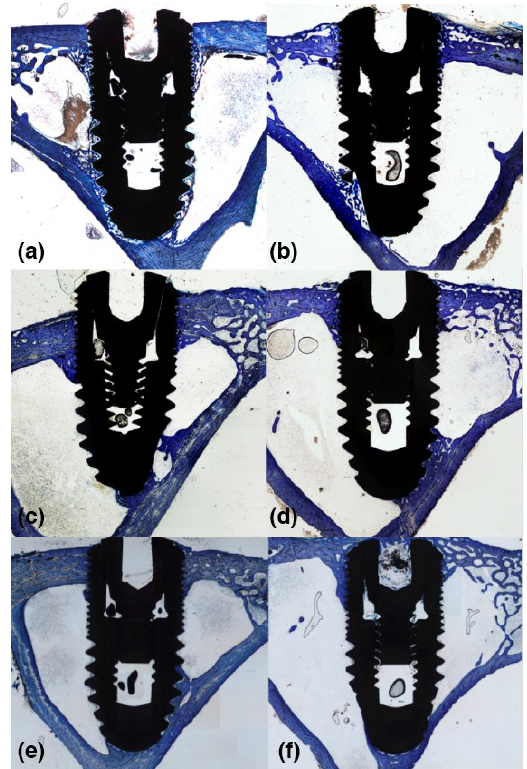
Figure 4. Ground section of bicortically-installed implants (Ticare Inhex ® , Mozo Grau, Valladolid, Spain) at diaphysis (left side) and metaphysis (right side) sites at two ( a , b ), four ( c , d ) and eight ( e , f ) weeks of healing. An original magnification of ×2.5 and toluidine blue staining was used.